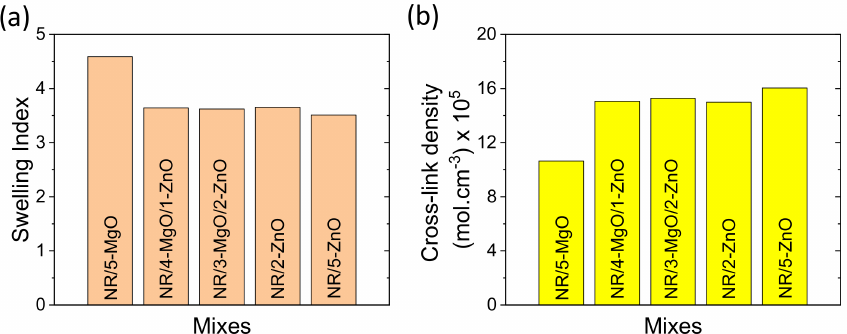
Figure 3. ( a ) Swelling index and ( b ) cross-link density of rubber vulcanizates.